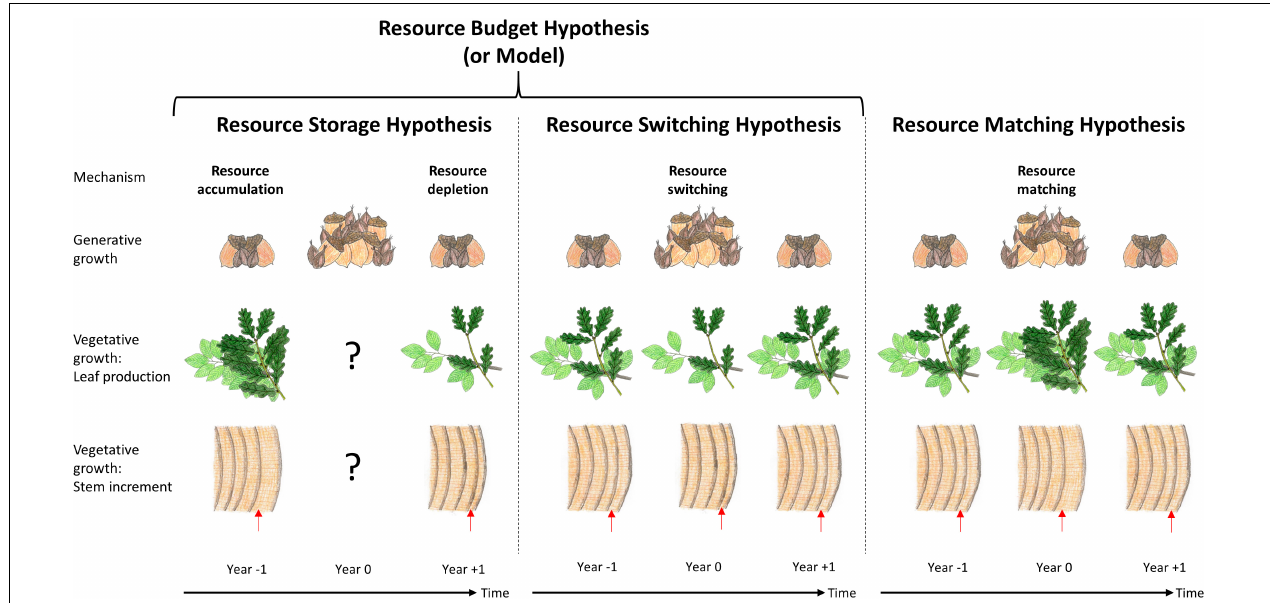
FIGURE 1 | Proximate mast hypotheses concerning resource dynamics: The resource storage hypothesis states that resources have to be accumulated before high amounts of fruits can be produced (resource accumulation). In the wake of the mast year, resources are depleted (resource depletion) and have to be accumulated again before another mast year occurs. The resource switching hypothesis assumes that during the mast year, resources are shifted from vegetative to generative growth. The resource matching hypothesis states that in environmentally favourable years, vegetative and generative growth are equally enhanced. ?: Resource dynamics in mast years can vary. Red arrows: Stem growth of the current year. Year –1 = 1 year before mast year, Year 0 = mast year, Year + 1 = 1 year after mast year. Original artwork by Anita